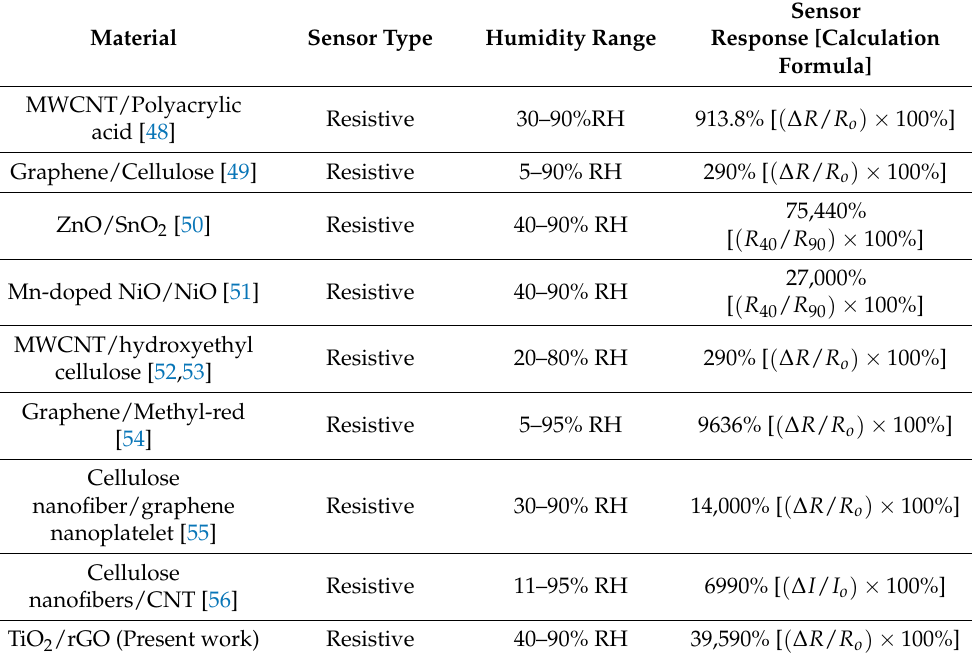
Table 3. Comparison of sensor response with other composite-based humidity